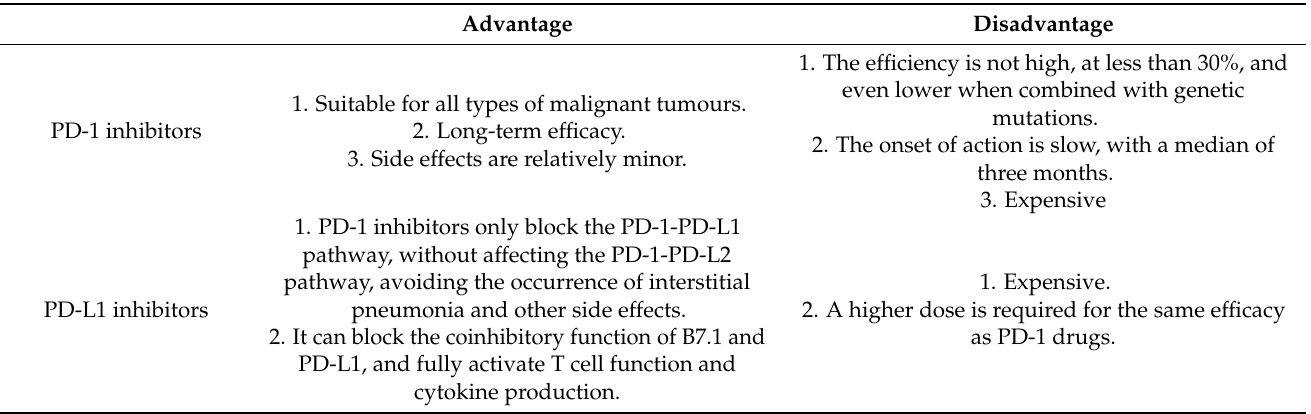
Table 2. The advantages and disadvantages of PD-1 and PD-L1